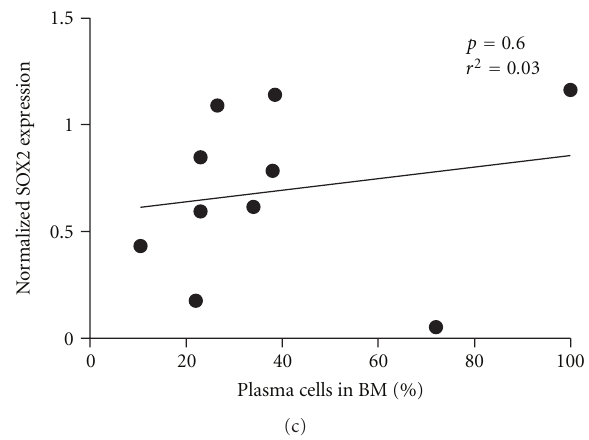
Figure 1: (a) RT-PCR analysis of SOX2 expression normalized to GAPDH in human tissues. BM from MM patients ( n = 25), healthy donors ( n = 15), myeloma cell lines ( n = 10), and 20 human tissues ( n = 1) was screened for SOX2 expression. Aqua dest. and non- reverse-transcribed mRNA were used as negative controls. 20 organs were tested for the presence of contaminating DNA. The resulting copy numbers (reverse-transcriptase-free) were normalized to GAPDH copy number of the respective tissue (cDNA). The mean value of all reverse-transcriptase-free results was calculated and included as the reverse-transcriptase-free (RT-free) condition. (b) FACS analysis of three MM patients’ BM, three BM of healthy donors, and three peripheral blood samples of healthy donors for SOX2 expression in gated CD138+ plasma cells. One BM sample (3) was found negative for SO2 protein expression. SOX2 expression was also found in 10 di ff erent myeloma cell lines. Isotype antibodies served as negative control for SOX2 expression. (c) Correlation analysis of SOX2 expression and percentage of plasma cells in the BM of MM patients. No significant association between SOX2 expression and the amount of plasma cells was found ( P = 0 . 6018, r 2 = 0 . 03556). HD: healthy donor; MM: multiple myeloma; BM: bone marrow; PB: peripheral